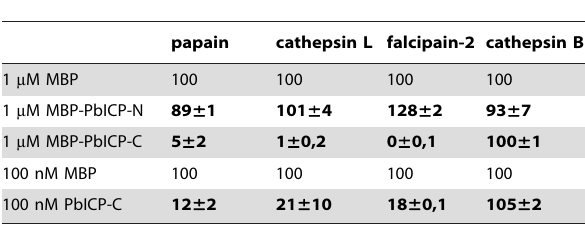
Table 2. The C-terminal domain but not the N-terminal domain of PbICP is a potent inhibitor of cysteine proteases except cathepsin